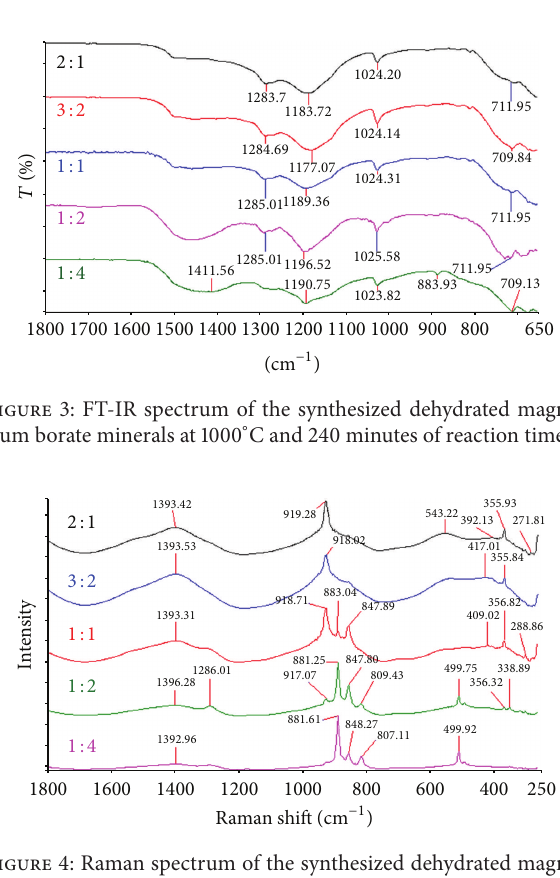
Figure 4: Raman spectrum of the synthesized dehydrated magne- sium borate minerals at 1000 ∘ C and 240 minutes of reaction time.